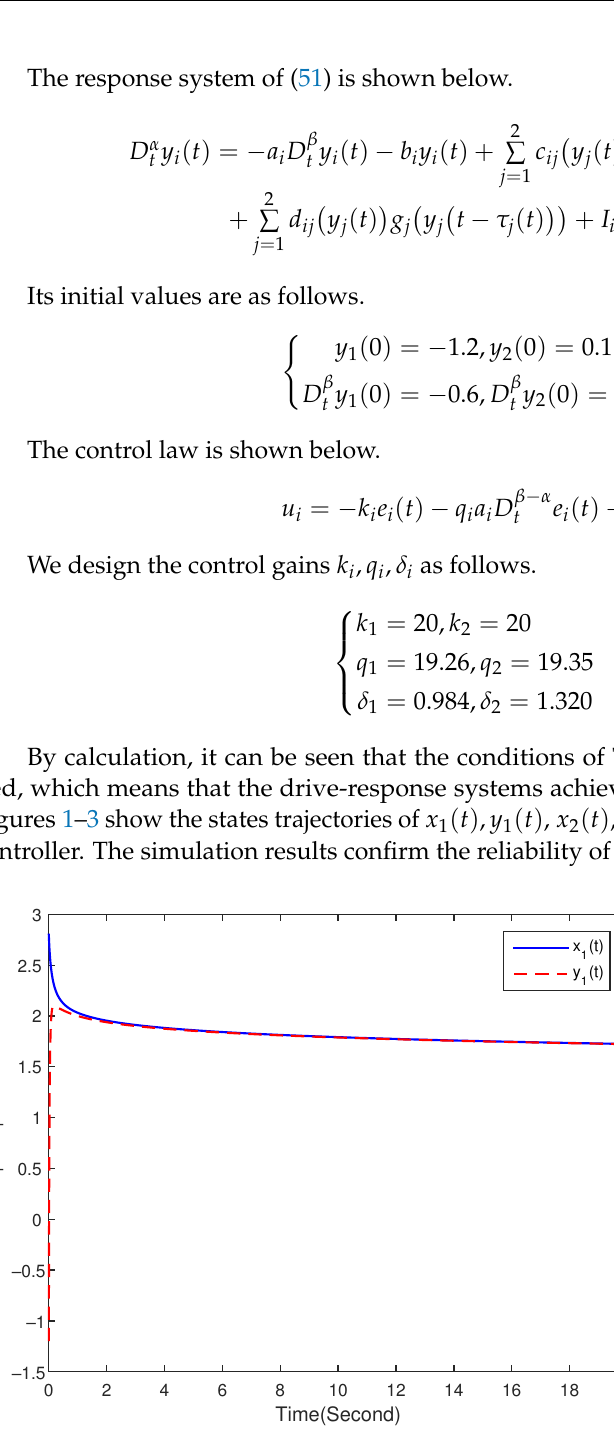
Figure 1. Trajectories of x 1 ( t ) and y 1 ( t ) with